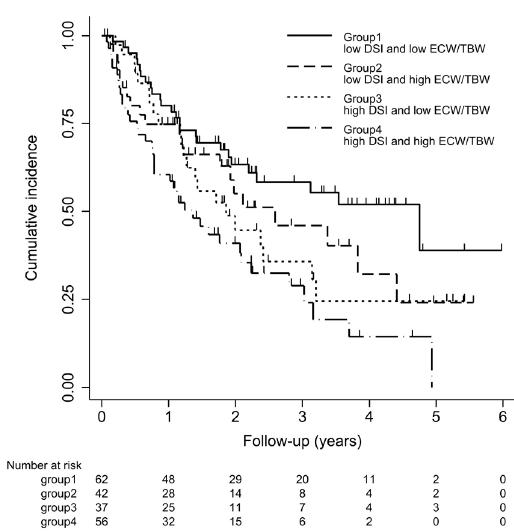
Figure 2. Correlation between DSI and ECW/TBW and systolic blood pressure. Relationship be- tween relative DSI and ECW/TBW ( A ), and between DSI and systolic blood pressure ( B ).